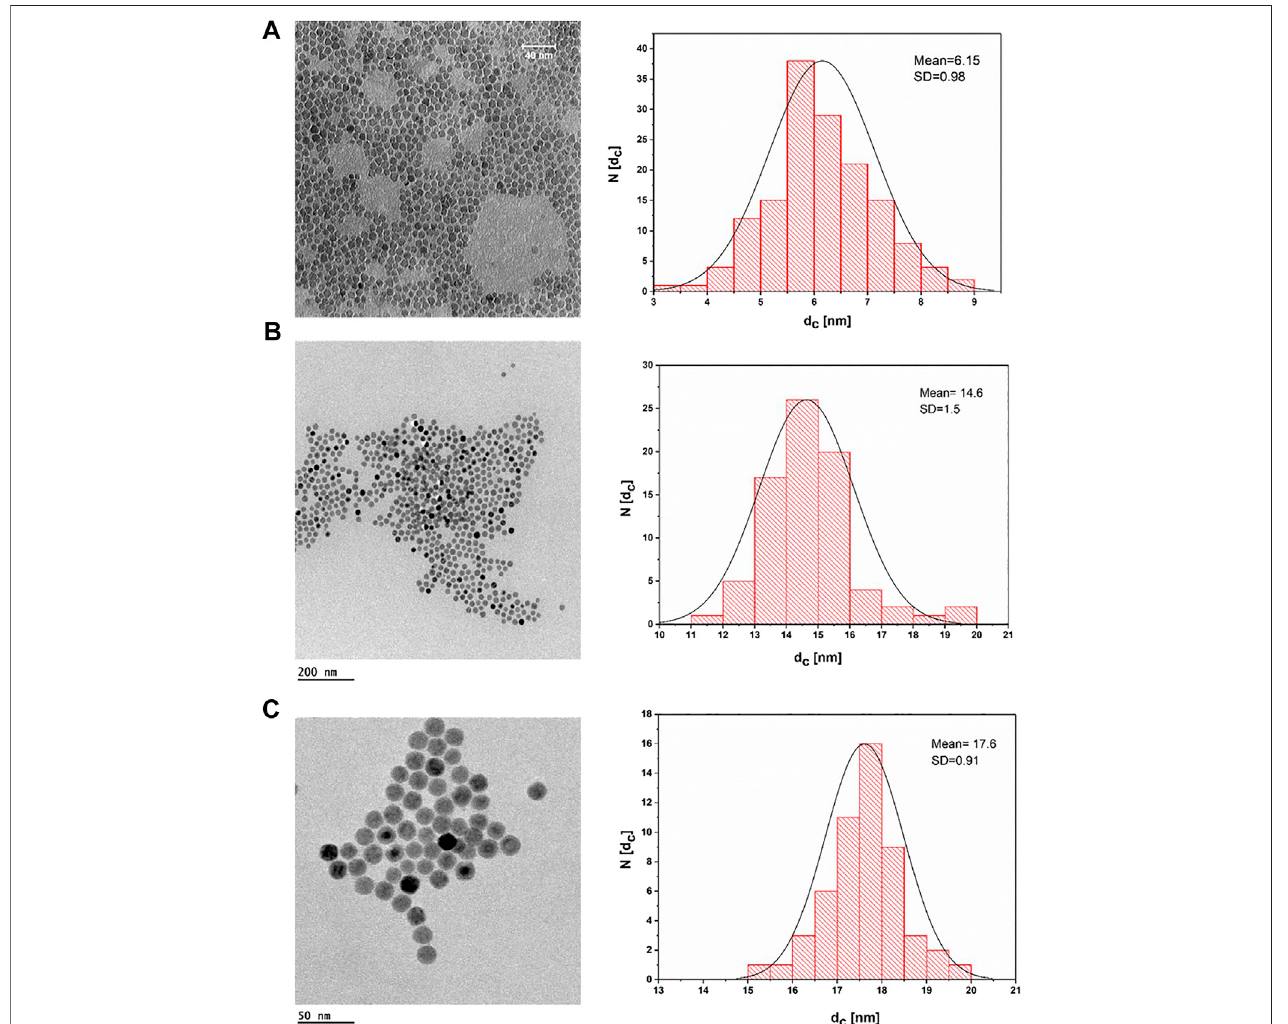
FIGURE 2 | TEM bright fi eld images of IONPs dried on a grid from a suspension of IONPs in hexane and their corresponding histogram, plotted as the number of NPs (N) that have a core diameter of d c . (A) IONPs with d c (cid:2) (6.5 ± 0.98) nm; the scale bar corresponds to 40 nm. (B) IONPs with d c (cid:2) (14.6 ± 1.5) nm; the scale bar corresponds to 200 nm. (C) IONPs with d c (cid:2) (17.6 ± 0.91) nm; the scale bar corresponds to 50 nm.